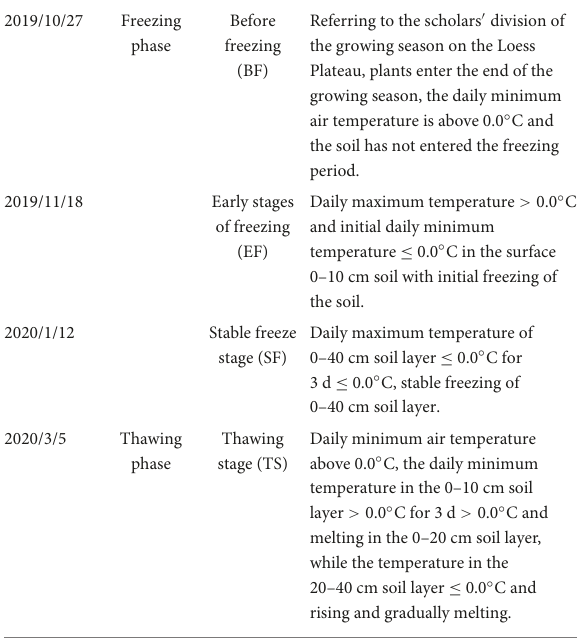
TABLE 3 Classification of each period of sampling time and basis of